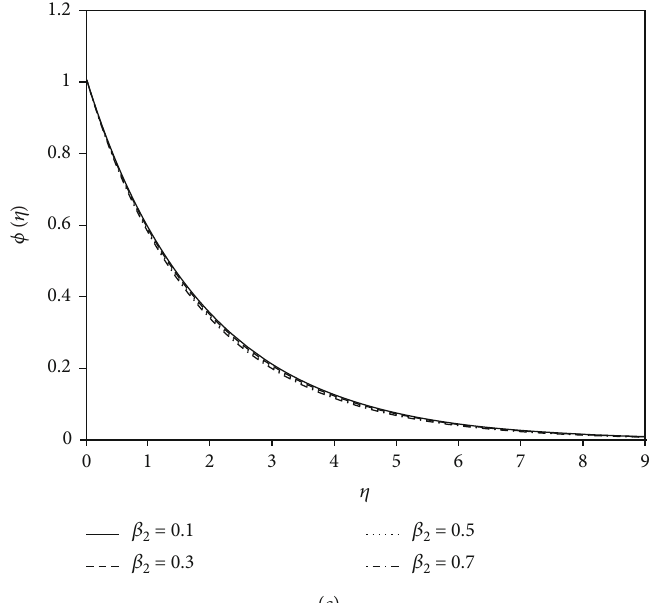
fi le. (b) Di ff erent values of β 2 on the velocity pro